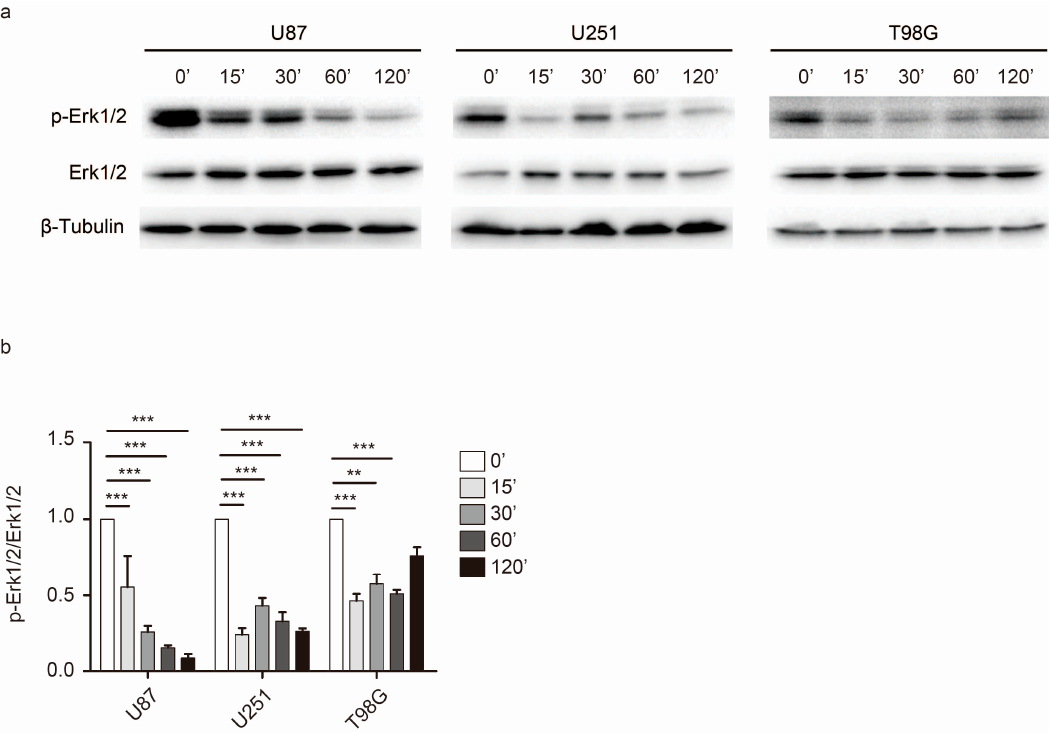
Figure 6. Rac1 regulates cell motility in Erk1 / 2 dependent way in GBM. ( a ) Western blot analysis of the level of phosphorylation of Erk1 / 2 in U87, U251 and T98G cells when responding to EHT 1864. ( b ) Histograms of the expression levels of phosphorylated Erk1 / 2 compared to total Erk1 / 2 in response to EHT 1864. ***: p < 0.001, **: p < 0.01. Uncropped blots are shown in Figure S7.